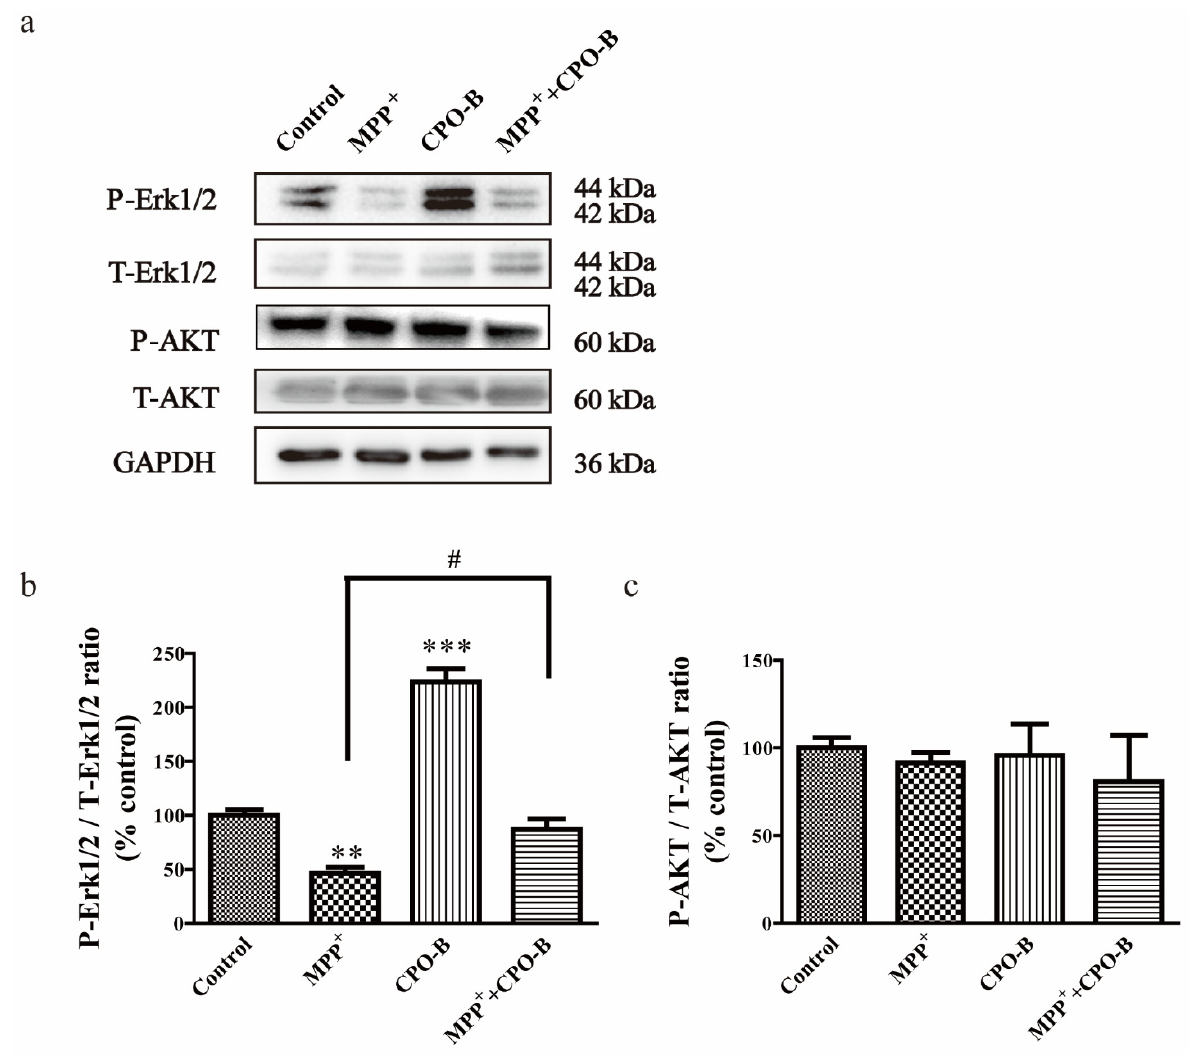
Figure 3. The effect of CPO-B on the MPP + -induced alteration of Erk1/2 ( b , n = 3) and Akt phosphorylation ( c , n = 3). The top panel in the figure shows representative Western blots ( a ). The values (mean ± SEM) were normalized to control; symbol * indicates the difference between control and other treatments; symbol # indicates the difference between MPP + and MPP + +CPO-B; ** p < 0.01, *** p < 0.001, # p < 0.05; CPO-B, B-type cinnamon procyanidin oligomer; MPP + , 1-methyl-4-phenylpyridinium; AKT, protein kinase B; P-AKT, phosphorylated AKT; T-AKT, total AKT; Erk1/2, extracellular signal regulated kinase 1 and 2; P-Erk1/2, phosphorylated Erk1/2; T-Erk1/2, total Erk1/2; GAPDH, glyceraldehyde 3-phosphate dehydrogenase.